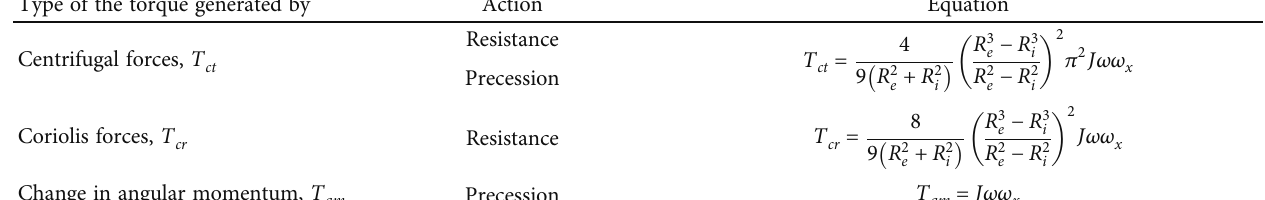
Table 2: The inertial torques acting on the spinning annulus generated by the external torque. Type of the torque generated